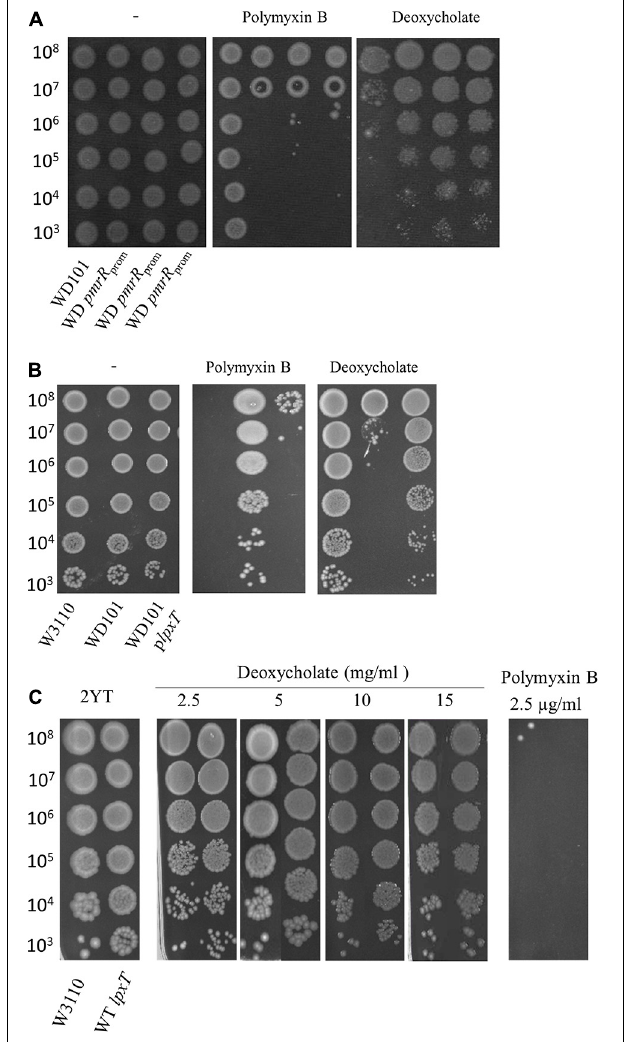
FIGURE 9 | Effect of LpxT expression/activity on polymyxin B and deoxycholate susceptibility. (A) WD101 and three individual clones of WD pmrR prom strain were grown overnight in 2YT medium and 5- µ l spots of serial dilutions were deposited on 2YT plates supplemented or not with polymyxin B (2.5 µ g/ml) and deoxycholate (2.5 mg/ml). (B) W3110, WD101, and WD101 carrying the plasmid p lpxT were grown overnight in 2YT medium and 5- µ l spots of serial dilutions were deposited on 2YT plates supplemented or not with polymyxin B (2.5 µ g/ml) and deoxycholate (2.5 mg/ml) (C) . W3110 and WT lpxT strains were grown overnight in 2YT medium and 5- µ l spots of serial dilutions were deposited on 2YT plates supplemented or not with polymyxin